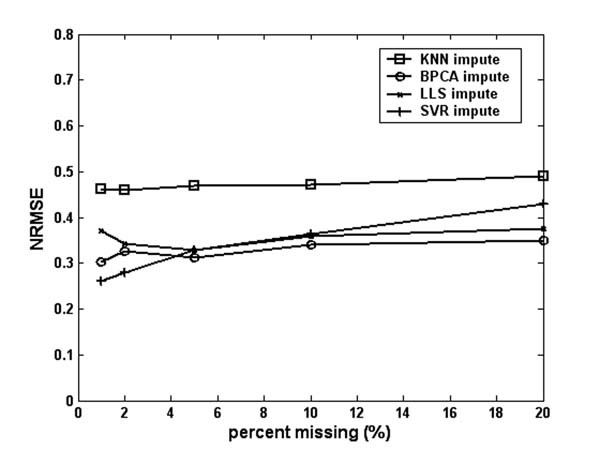
Performance of the four methods on data I.